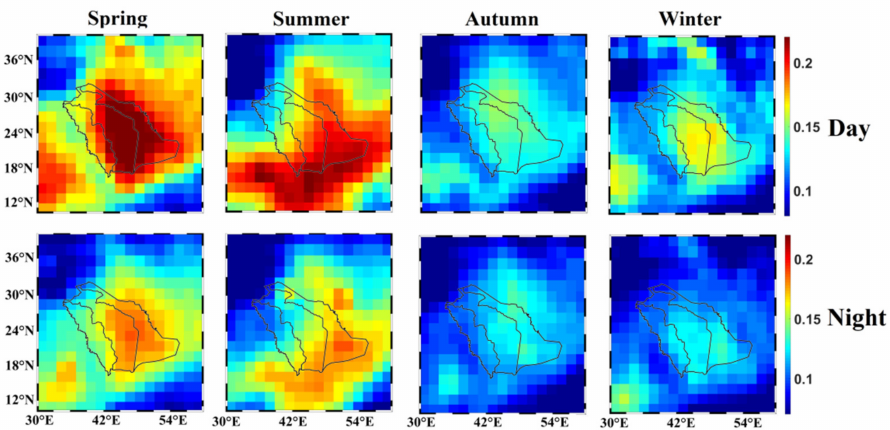
Figure 13. Seasonal spatial distributions of CR 1 over Saudi Arabia from 2007 to 2019.